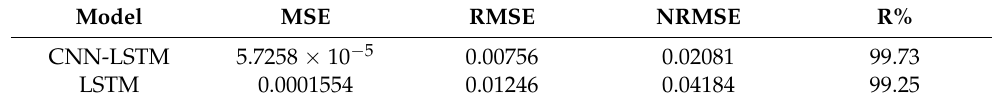
Table 5. Deep learning results for predicting the closing price of Apple during the testing phase.